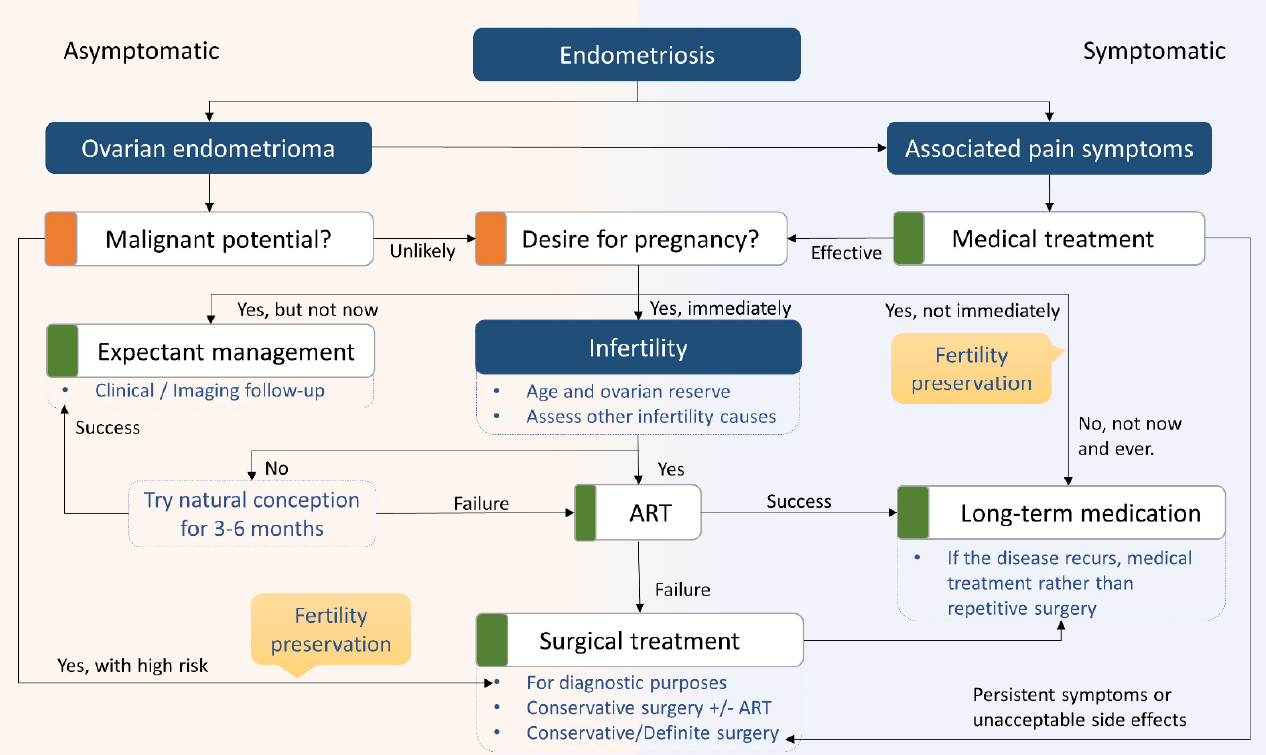
Figure 5. Treatment algorithm of endometriosis.